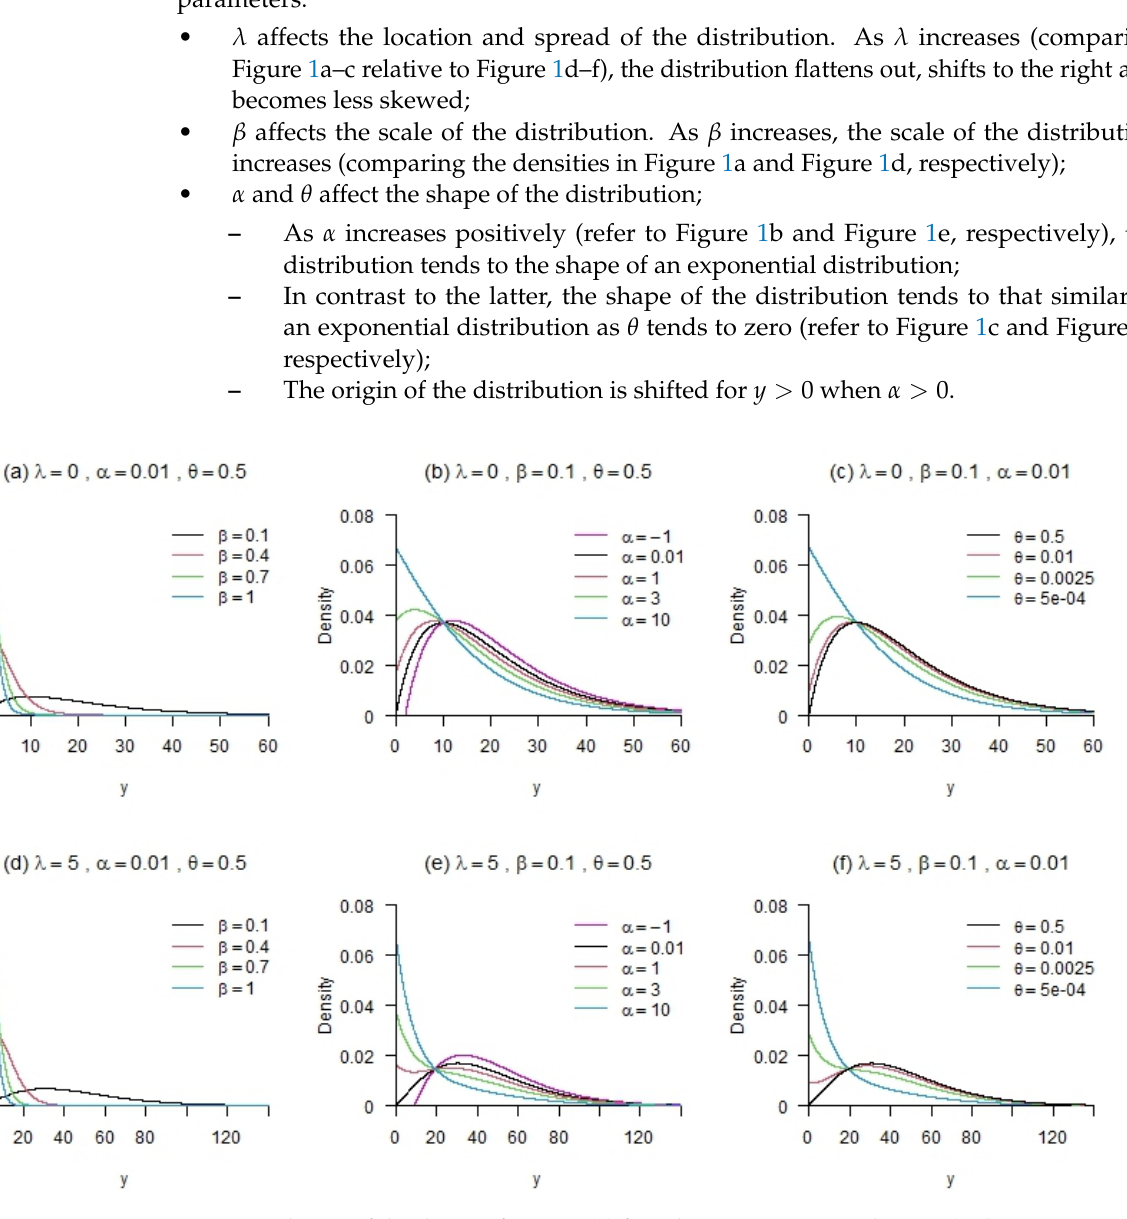
Figure 1. Shapes of the density function (5) for arbitrary parameter choices. ( a – f ) some particular shapes of the density function for various combinations of